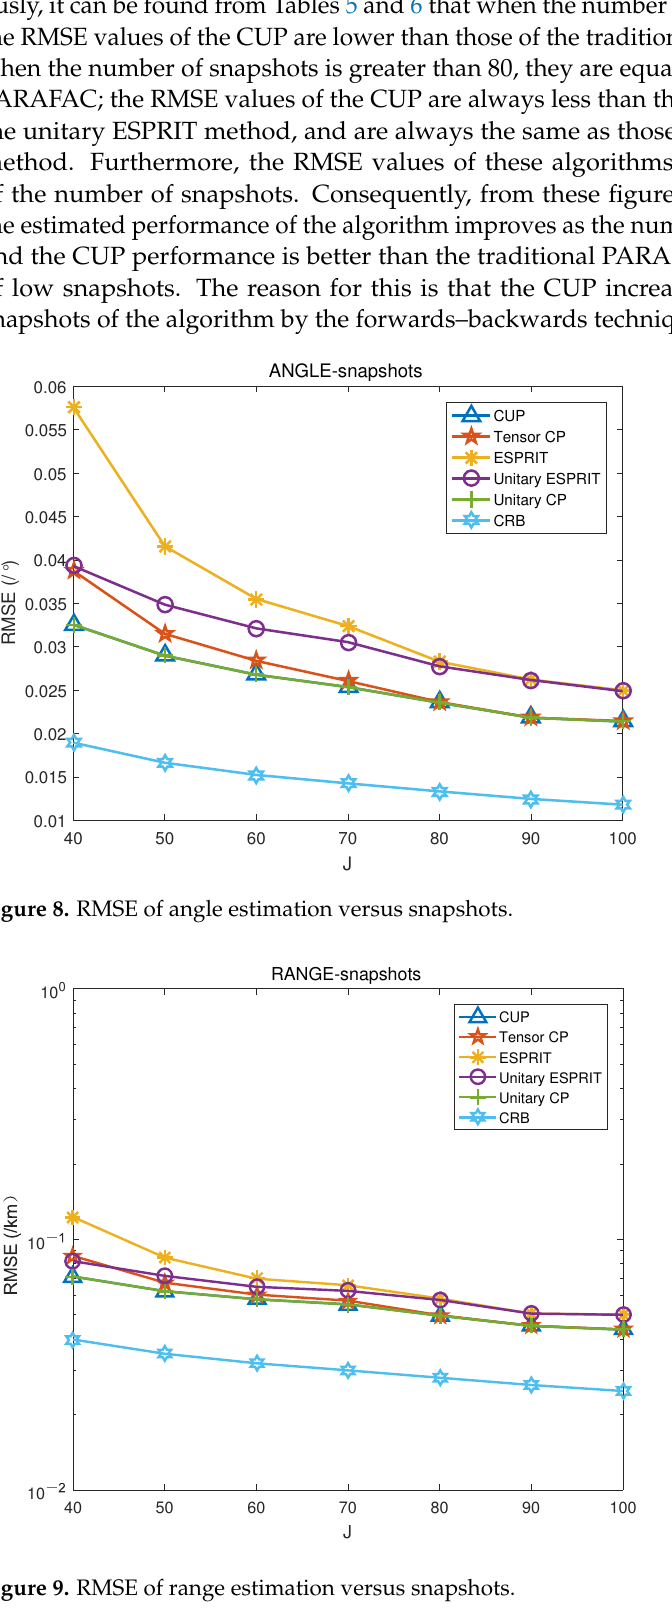
Figure 9. RMSE of range estimation versus